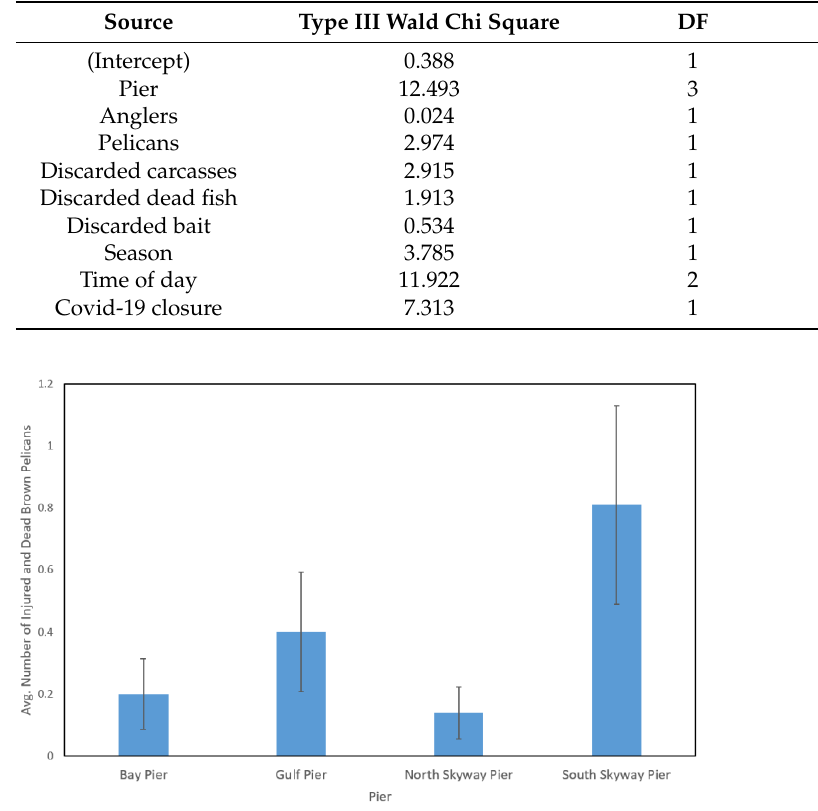
Table 2. Significance of factors predicting injured and dead Brown Pelicans using a general linear model. DF = degrees of freedom; Sig. = statistical significance ( p ).